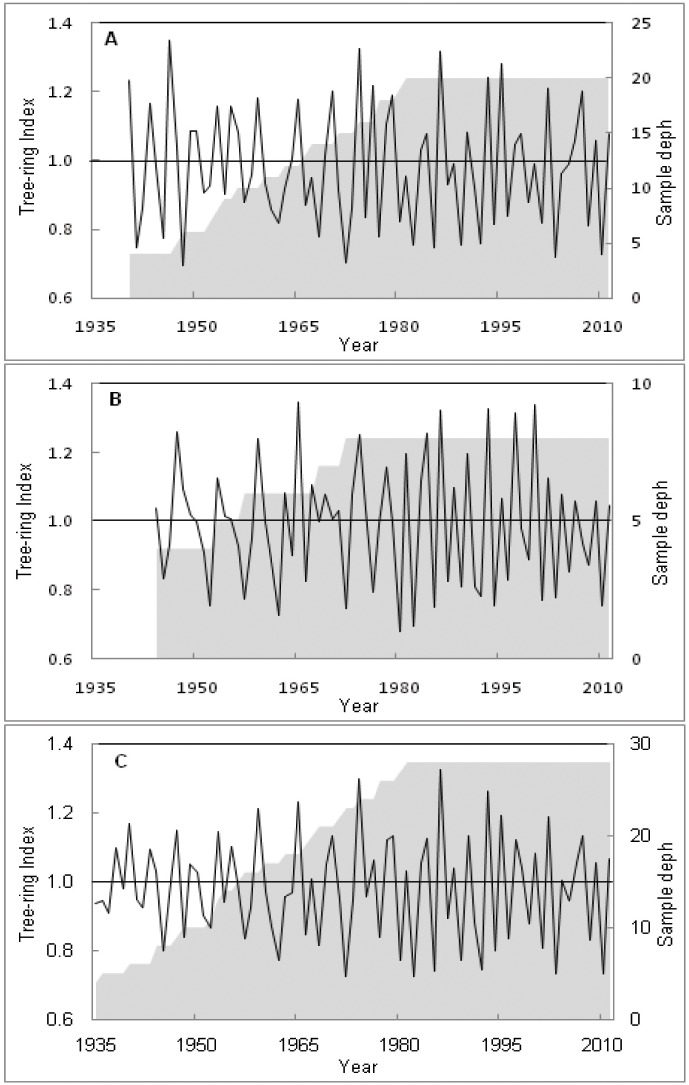
The standardized chronologies of the eastern (A) and western (B) zone. The regional chronology is shown in C.Solid line indicates the chronology and shadow indicates the sample depth in each case.